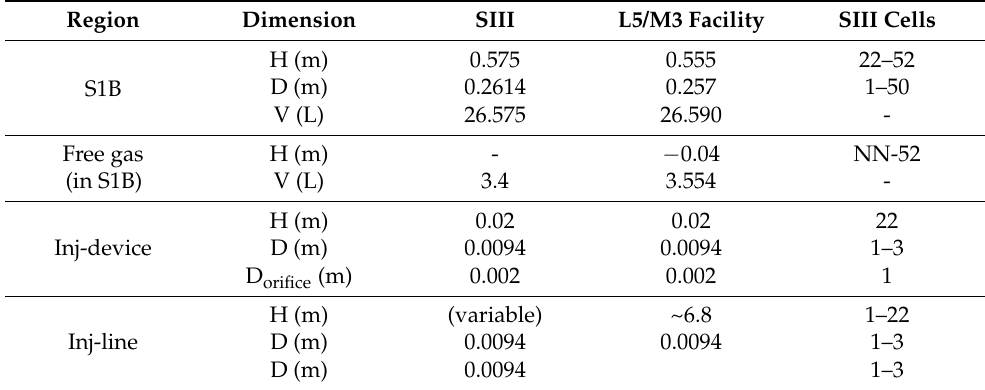
Table 4. SIMMER-III reference model and LIFUS5/Mod3 facility: main dimensions.